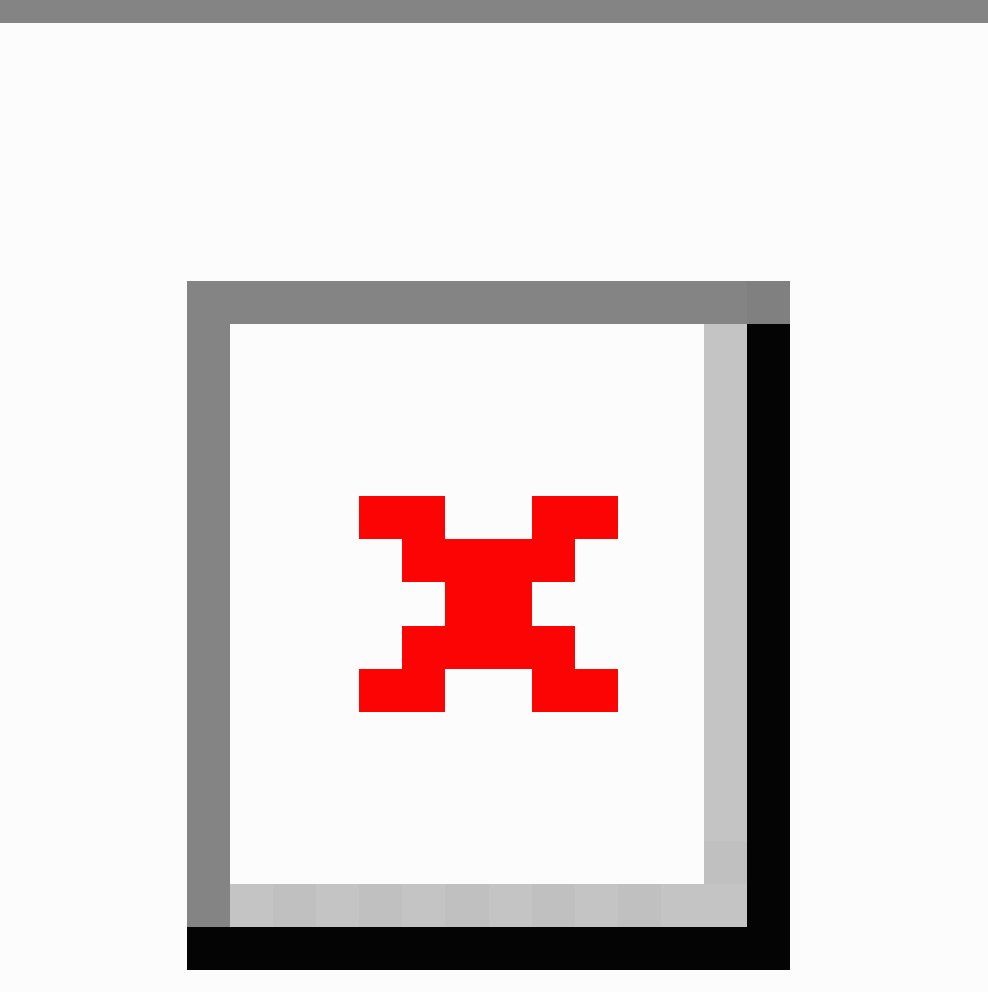
Figure 1. A world map showing the number of cases for each country with a coronavirus disease case.